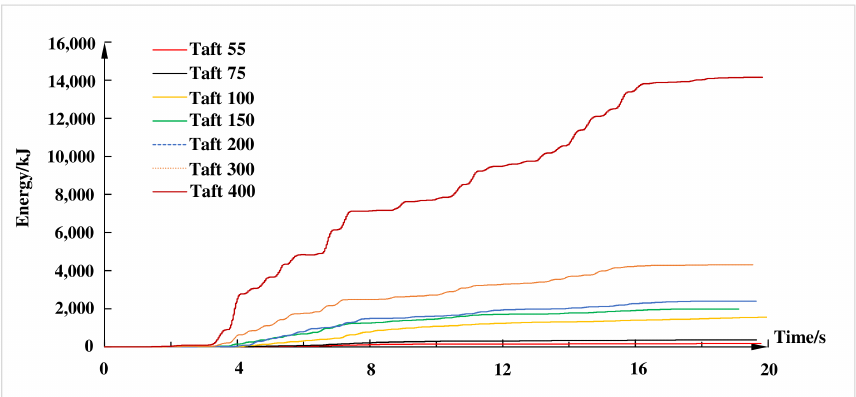
Figure 13. Hysteretic energy dissipation capacity curves of structure.